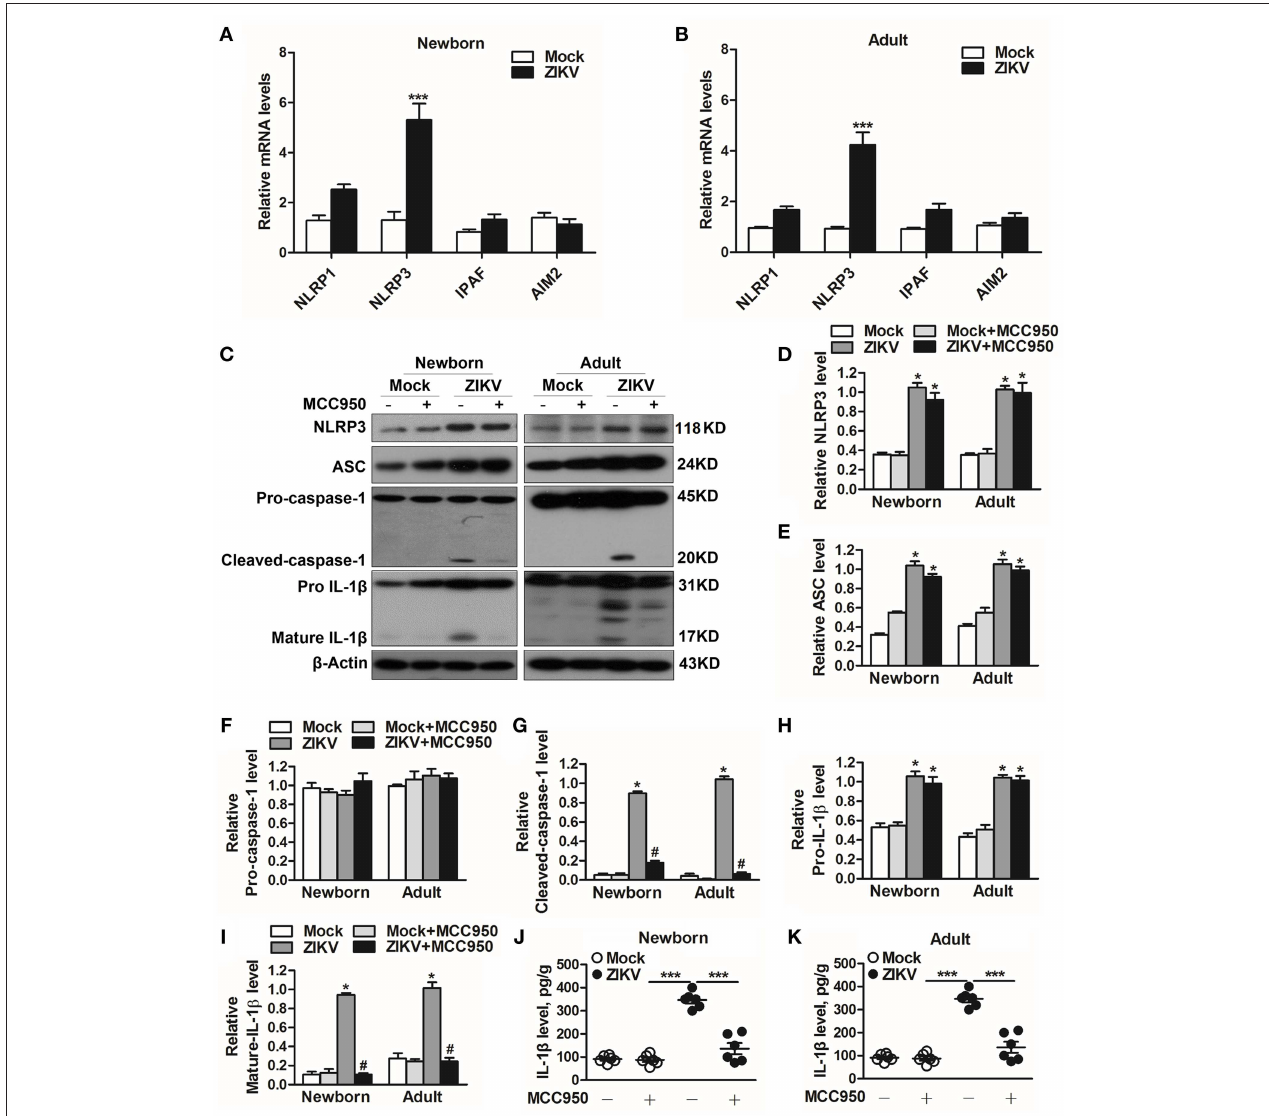
FIGURE 5 | ZIKV infection induced NLRP3 inflammasome activation in the kidneys. (A,B) The relative mRNA levels (vs. mock group) of NLRP1, NLRP3, IPAF, and AIM2 in the kidneys of mock and ZIKV-infected newborn (A) and adult (B) mice at 7 days post-infection were detected by qRT-PCR. (C–I) Expression levels of NLRP3 (D) , ASC (E) , pro-caspase-1 (F) , cleaved-caspase-1 (G) , pro-IL-1 β (H), and mature IL-1 β (I) in the kidneys of newborn and adult mice at 7 days post-infection were assessed by western blot. (J,K) Examination of mature IL-1 β release in the supernatants of mouse kidneys at 7 days post-infection ( n = 6 per group) were determined by an enzyme-linked immunoadsorbent assay (ELISA). Data were presented as mean ± SEM ( n = 6), * p < 0.05 vs. mock group; # p < 0.05 vs. ZIKV group (*** p < 0.001 vs. mock group or ZIKV + MCC950 group in Figure J and